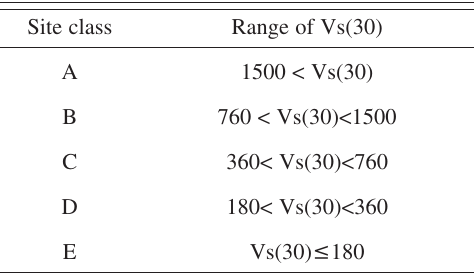
Table I. NEHPR site classes based on Vs(30), (BSSC,